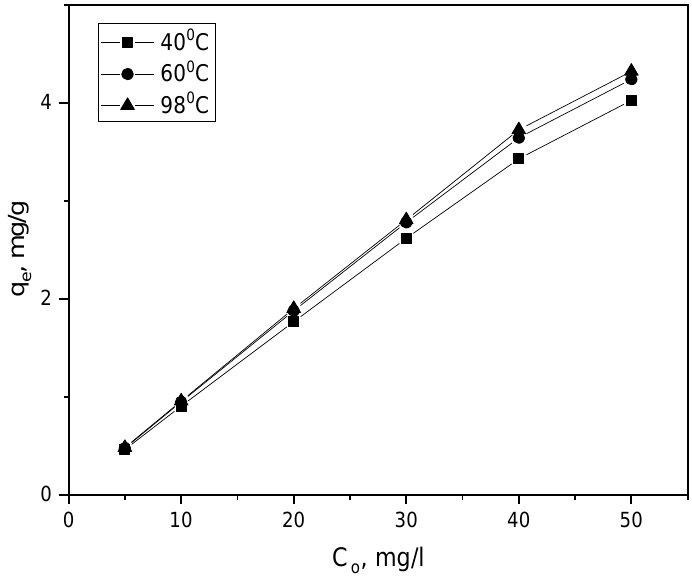
Figure 2. Adsorption capacity of polyamide 6.6 fabric during dyeing in relation to the initial concentration and temperature